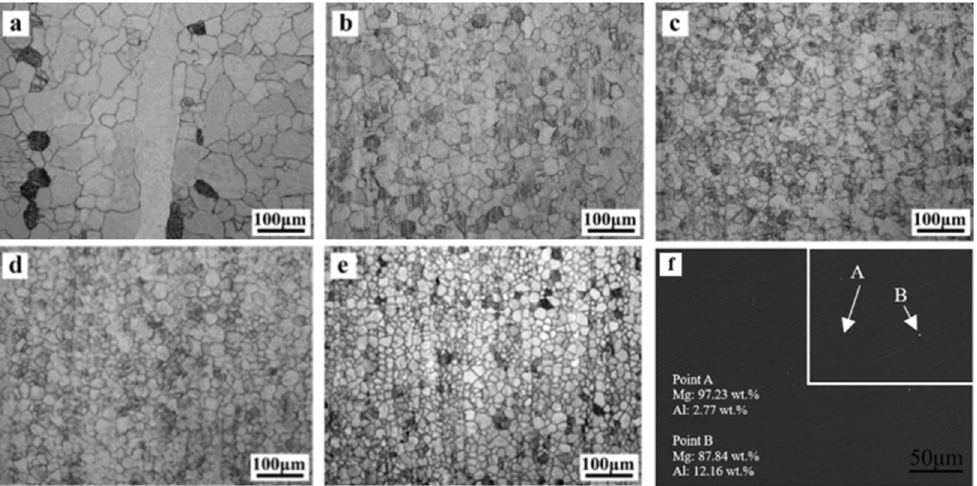
Figure 4. Optical microscope images of the as-extruded Mg–Al alloys with different Al content along the extrusion direction: ( a ) Mg, ( b ) Mg–1Al, ( c ) Mg–2Al, ( d ) Mg–3Al, ( e ) Mg–4Al, and ( f ) SEM image obtained from Mg–4Al alloy.